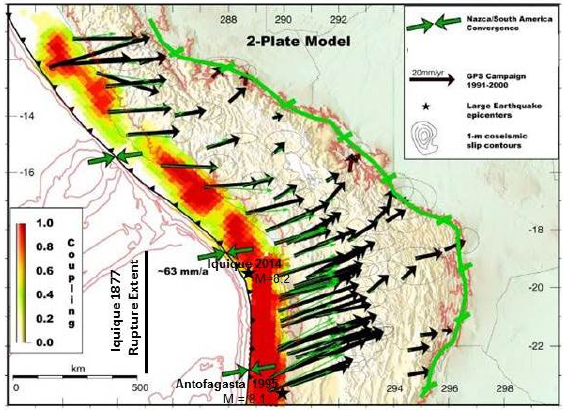
Figure 2: Distribution of interseismic coupling coefficient in the Peru Chile subduction zone. The coefficients are determined based on geodetic data (Chlieh et al., 2011). Black and green arrows are observed and predicted horizontal GPS displacements, respec-